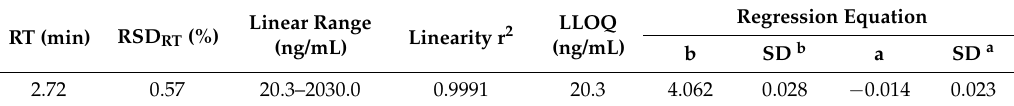
Table 1. Calibration and selected performance parameters of developed HPLC-Q-TOF method for Nec-1s in rat plasma.